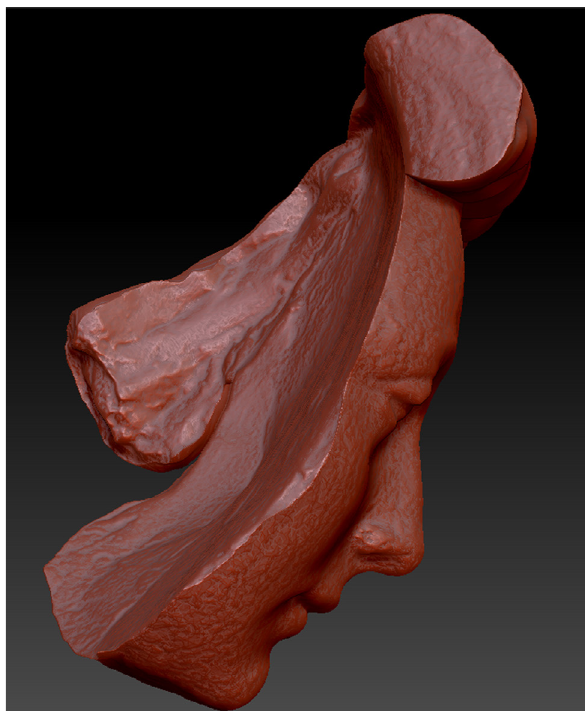
Figure 8. The virtually reconstructed missing part of a female figure: the face and the head cover has been moulded on the surviving surface to obtain a watertight model used as Ground Control Points and Check Points (Stavropoulou et al.